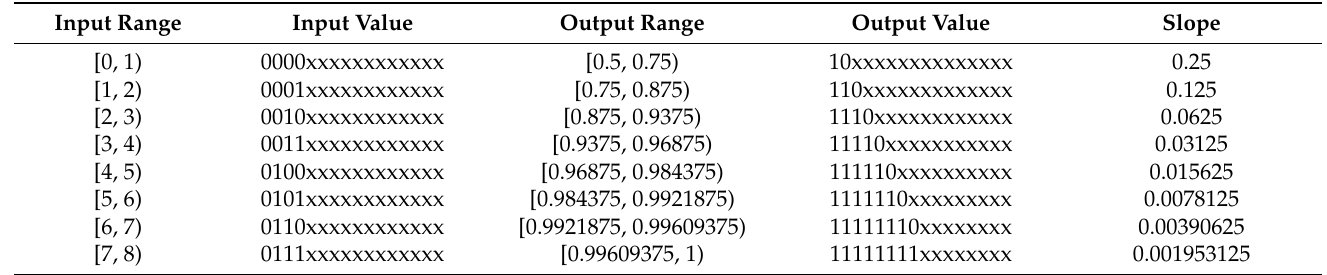
Table 1. The truth table of the 15-segment polyline approximates the sigmoid function for x >